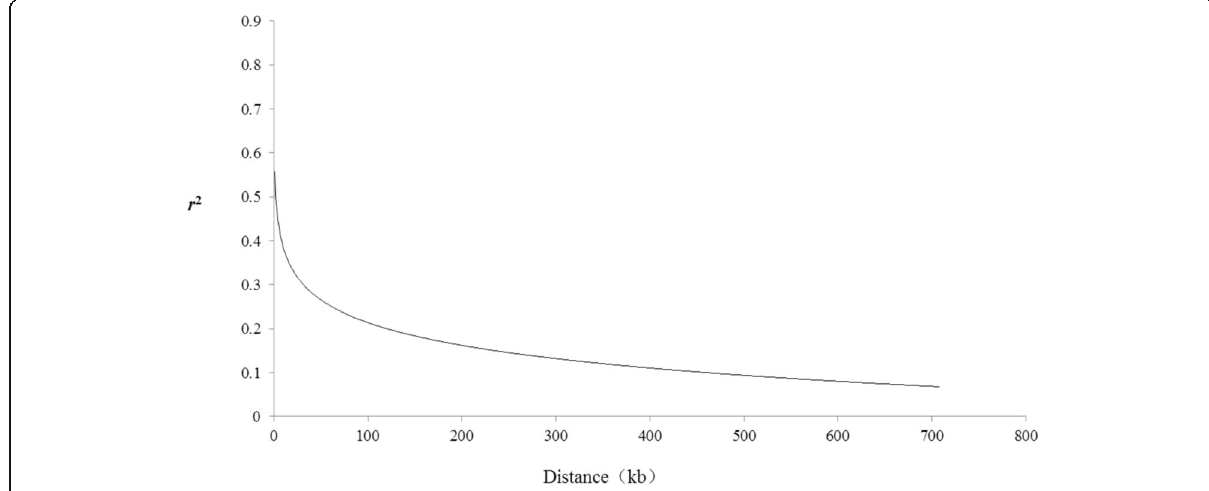
Fig. 8 Genome-wide average LD decay estimated from 323 rice